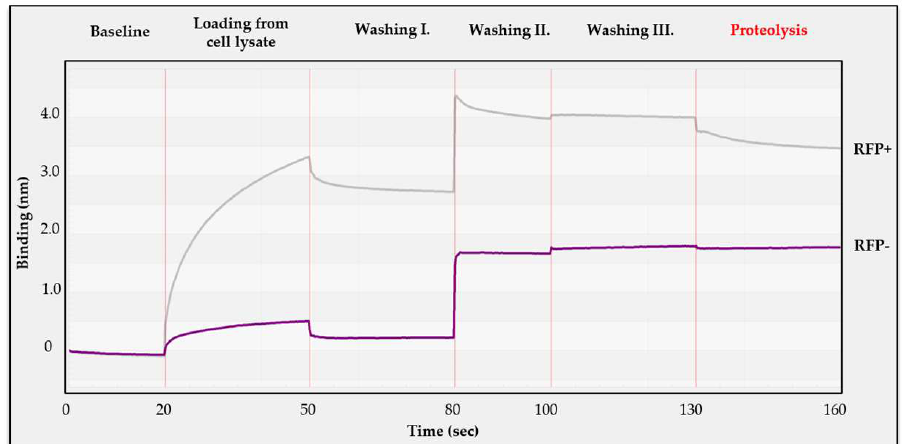
Figure 9. Cleavage reaction performed with non-purified RFP substrate on BLItz instrument. On a Ni-NTA biosensor, a baseline was initially established (tube-mode), then the sensor was merged into the cell lysate either containing (RFP+) or lacking (RFP − ) the His 6 -MBP-VSQNY*PIVQ-mEYFP substrate, until saturation were reached (drop-mode). Three individual washing steps were added to remove non-specifically bound proteins (tube-mode). Finally, HIV-1 PR wt was added to the reactions (drop-mode) and the signal change was